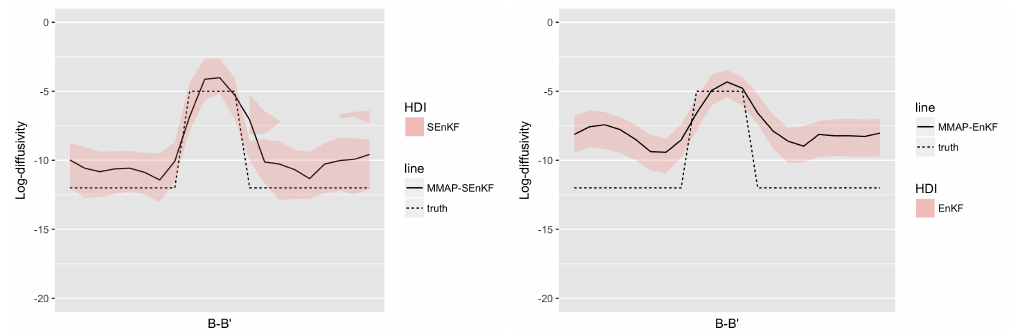
Figure 9. MMAP predictions of the log diffusivity field with 80% HDI in cross section B-B’ at time T = 100 with SEnKF ( left ) and with EnKF ( right ).